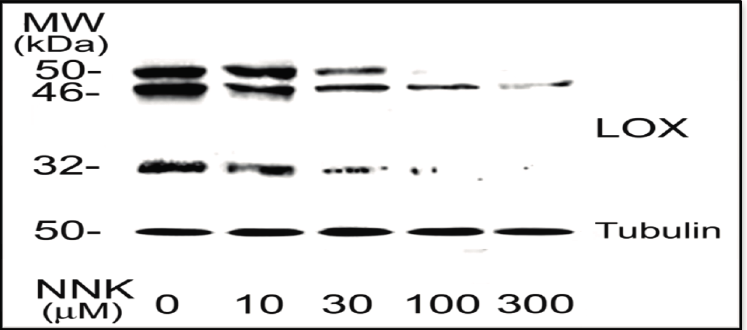
Figure 2. NNK inhibition of LOX protein profile in treated cells. Growth-arrested RFL6 cells were treated with NNK at 0–300 µM for 48 h. Total cell proteins were extracted and aliquots of protein samples (25 µg each) were analyzed on SDS-PAGE and detected by Western blot and densitometry measurement. The 46-, 50- and 32- kDa proteins are LOX species, the bottom protein is tubulin with 50 kDa, an internal control. Experiments were repeated three times, one of which is presented